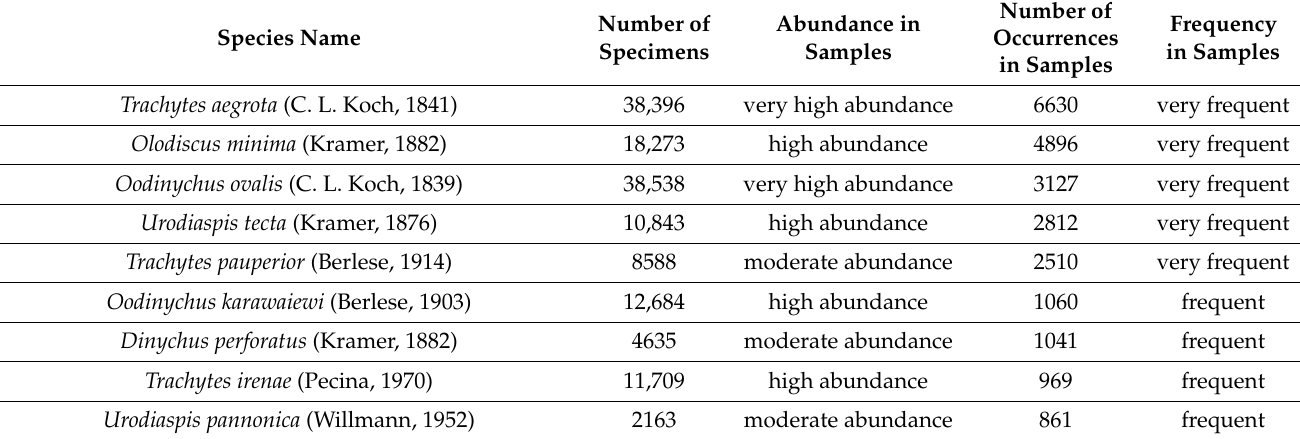
Table 1. Abundance and frequency of occurrence of Uropodina species in analysed